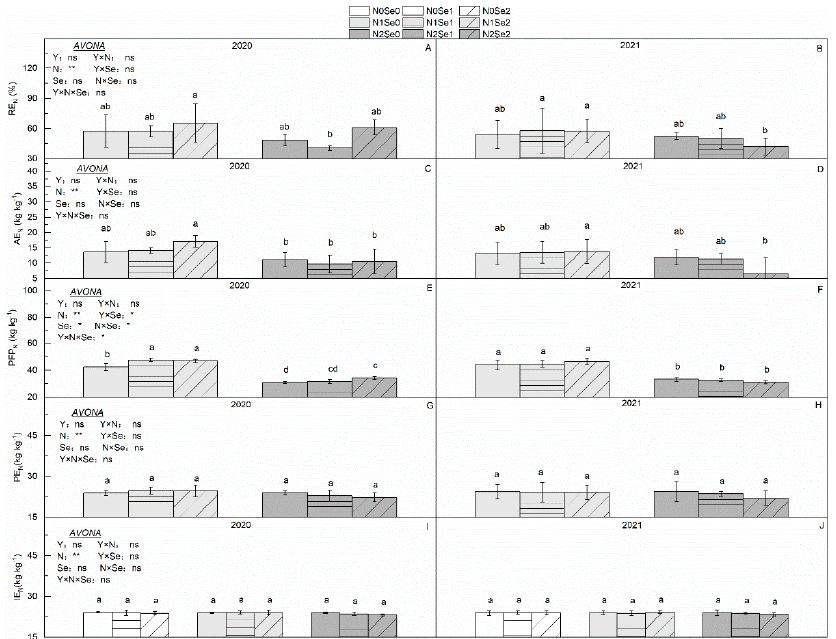
Figure 2. Effects of selenium and N fertilizers on N use efficiency in wheat. Y = Years, N = Nitrogen, Se = Selenium. ( A , C , E , G , I ) represent RE N , AE N , PFP N , PE N , IE N in 2020, respectively. ( B , D , F , H , J ) represent RE N , AE N , PFP N , PE N , IE N in2021, respectively. N0, N1 and N2 indicate 0 kg N ha − 1 , 180 kg N ha − 1 and 270 kg N ha − 1 , Se0, Se1 and Se2 indicate 0 g Se ha − 1 , 450 g Se ha − 1 and 900 g Se ha − 1 . Different lowercase letters indicate statistical differences among the treatments at p < 0.05. “ns” means no significant difference ( p > 0.05). * and ** represent the significance levels of p < 0.05 and p < 0.01, respectively.